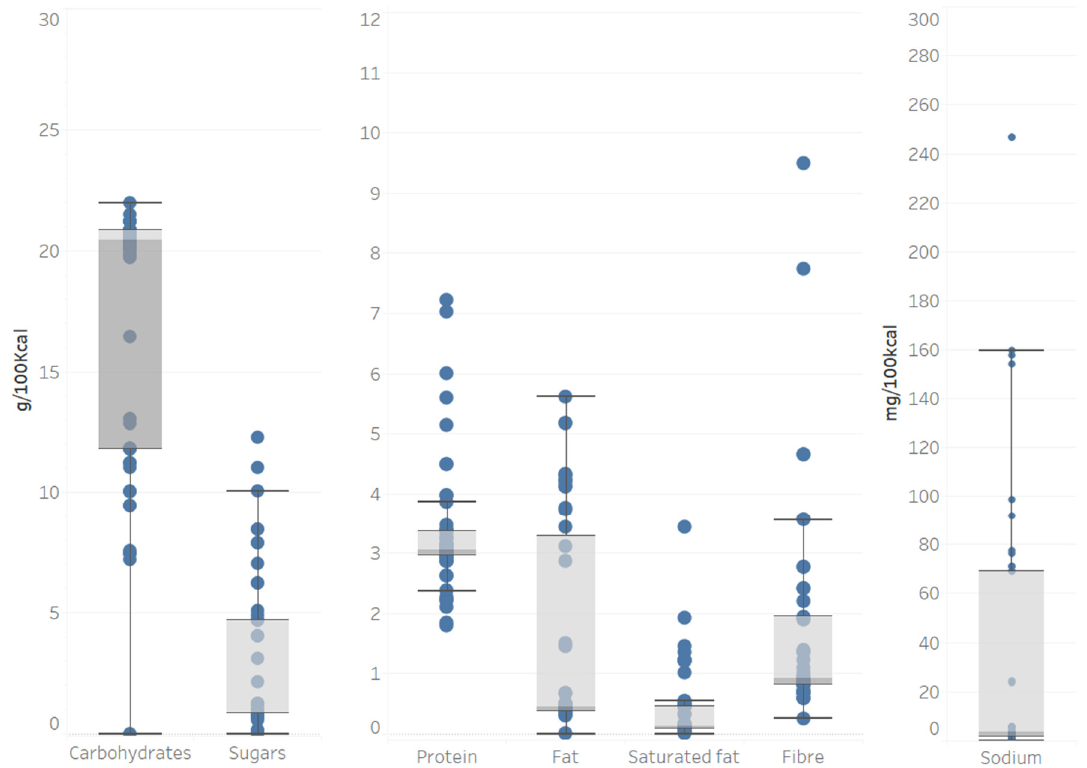
Figure A7. Nutrient content (g/100 kcal product, except for sodium mg/100 kcal product) of ‘Baby savoury meals and dishes.